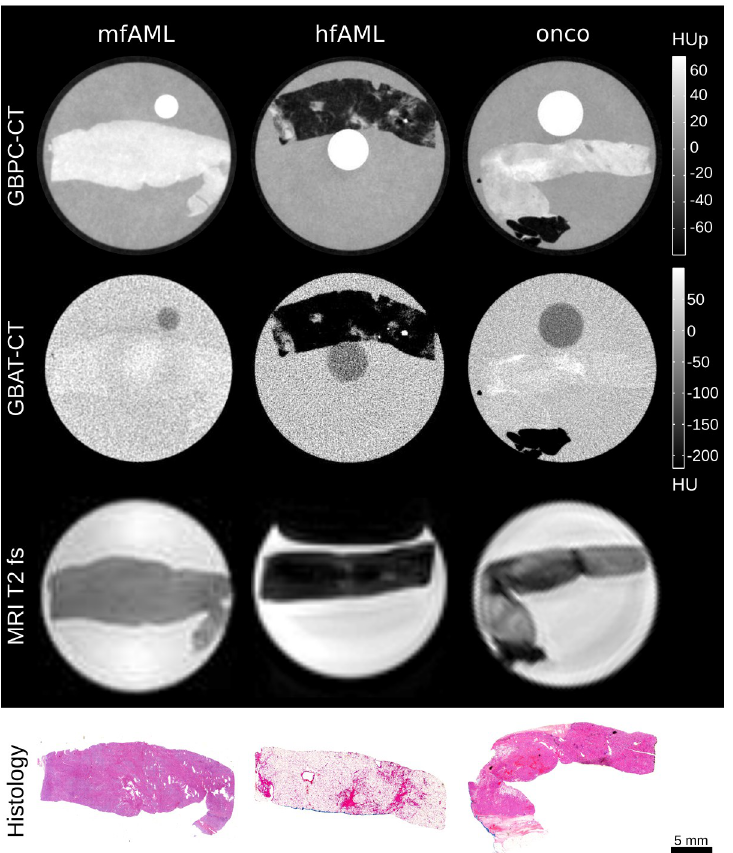
Fig 2. Preclinical imaging results of benign kidney lesions in histopathological correlation. Typical slices of a mfAML, hfAML and oncocytoma (onco) obtained with GBPC-CT, GBAC-CT and T2 fat saturated MRI (MRI T2 fs). The bottom row displays the corresponding histological slices that were obtained for validation with HE-staining. HU: Hounsfield units, HUp: Hounsfield units phase, mfAML: minimal-fat angiomyolipoma, hfAML: high-fat angiomyolipoma, onco: oncocytoma, GBPC-CT: grating-based phase-contrast computed tomography, GBAC-CT: grating-based attenuation-contrast computed tomography, MRI T2 fs: magnetic resonance imaging with T2 fat